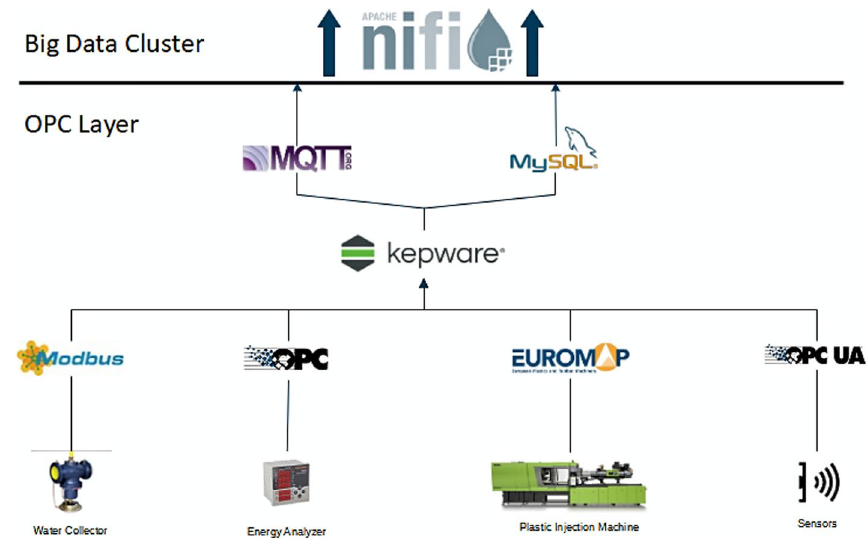
Fig. 6 Data digitalization schema of DataCone.The data is collected from 4 different types of devices, and it is published to the big data platform over two different methods. MQTT protocol is used to transfer streaming data such as voltage, current, pressure, flow, etc. Batch data is inserted into a MYSQL database after each machine cycle is finished. The shop floor data is transferred to the big data platform using those